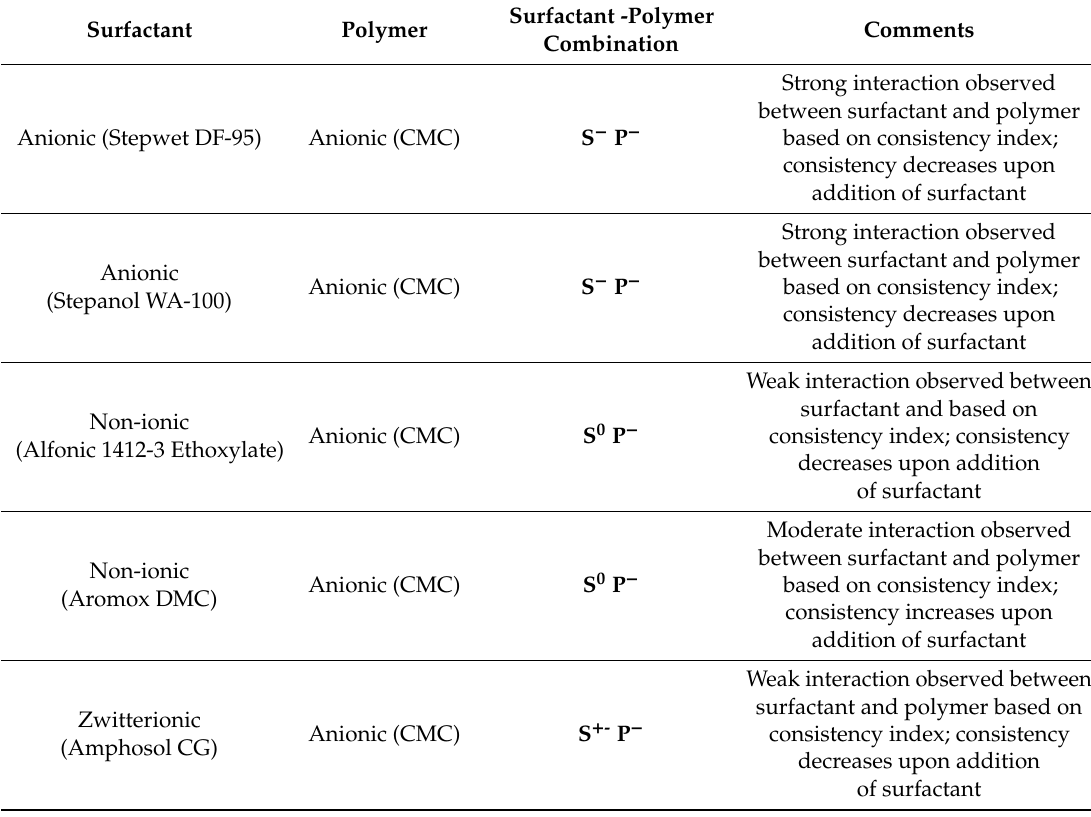
Table 3. Summary of interactions between polymer and